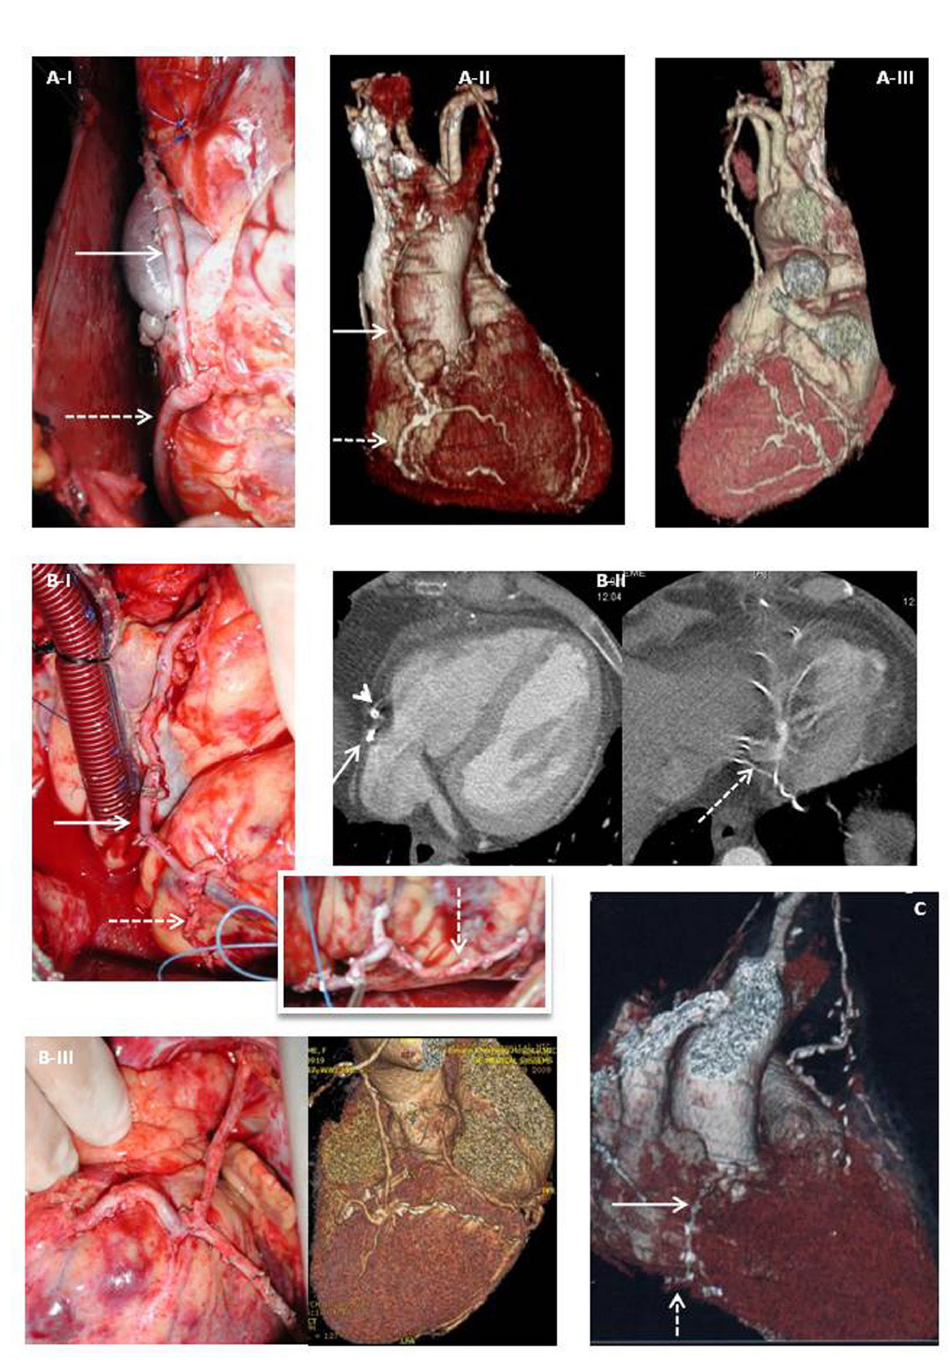
Fig. 2 - The arterial Inflow modes by in situ RITA (IRTG) and coronaro-coronary grafting (CRTG). A-I: operative view of an ITRG with in situ RITA. A-II: postoperative CT angiography showing the arterial inflow (arrow) and ICB (dashed arrow). A-III: the postoperative CT-angiography of the left-sided composite arterial graft (endarterctomized LAD with extensive arterial roofing). B-I: operative view of CRTG: arrows and dashed arrows show the arterial inflow and ICB respectively. BII: postoperative CT angiography of CRTG. The head of arrow shows the native RCA with in-stent stenosis. The arrow displays the arterial inflow and ICB at the level of their composite anastomosis. B-III: operative view and postoperative control of the left-sided composite arterial graft. C-I: preoperative coronary angiography displaying an occluded RCA and LAD in a patient with three vessel disease. The arrows show an acute marginal branch and distal RCA. C-II: the post-operative CT angiography showing the patent CRTG (arrow: arterial inflow; dashed arrow: ICB). [ICB: free LITA; Inflow mode: CRTG using radial